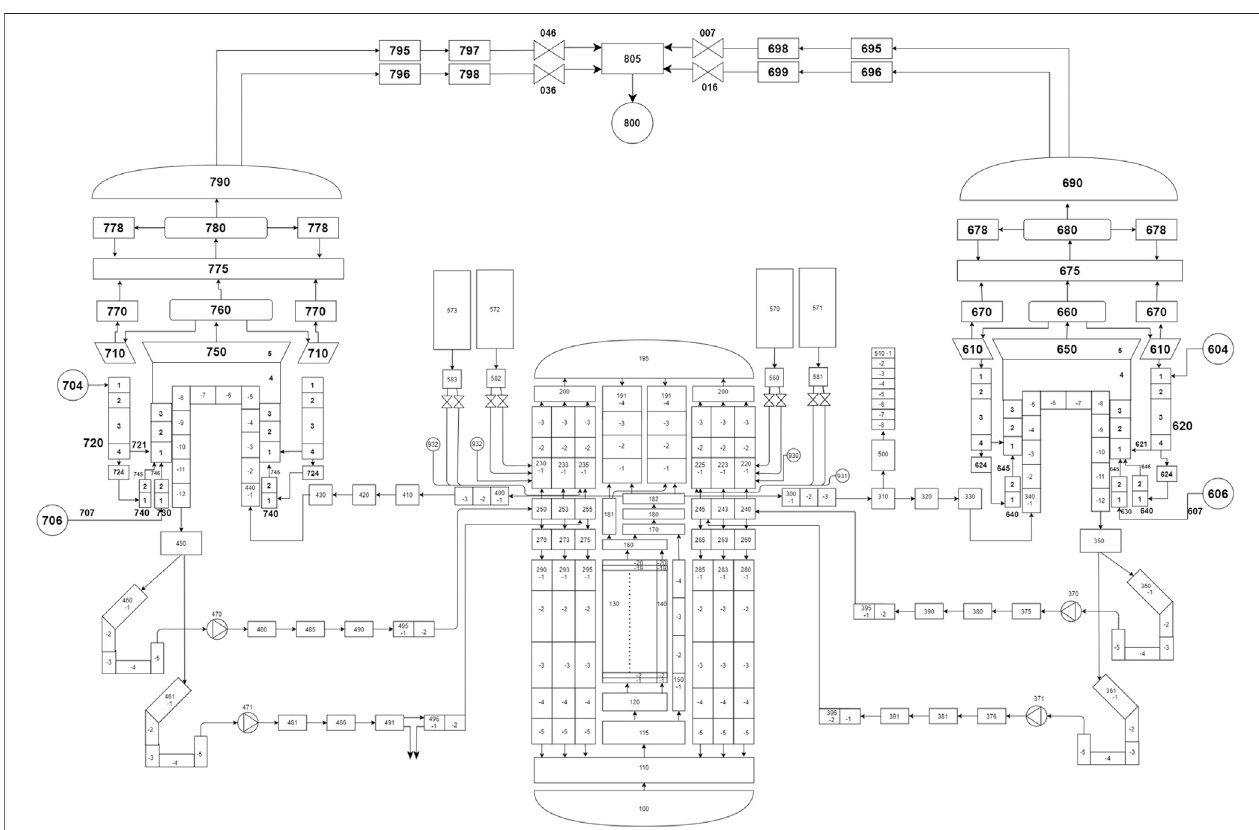
FIGURE 1 | APR1400 nodalization for the LBLOCA thermal-hydraulic